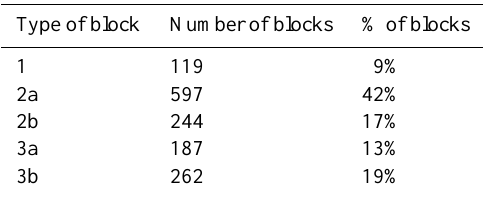
Fig. 7. Curves corresponding to the DPM-2007 for three MM in- tensities (VII, VIII, and IX) and five types of residential blocks. Table 6. Distribution of the different types of residential blocks in Colima.